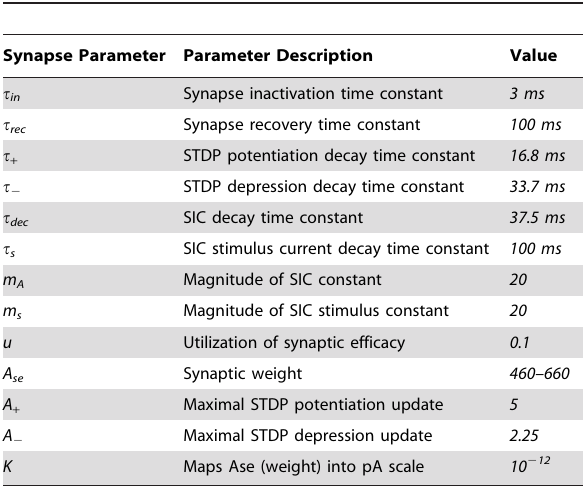
Table 3. Synapse